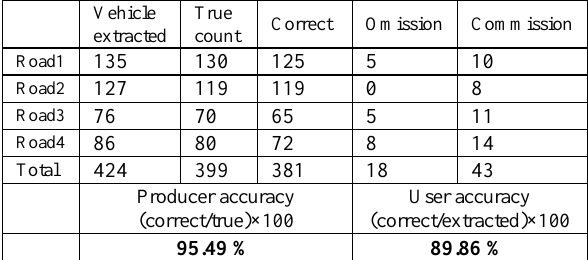
Table 1: Accuracy of vehicle detection from WorldView-2